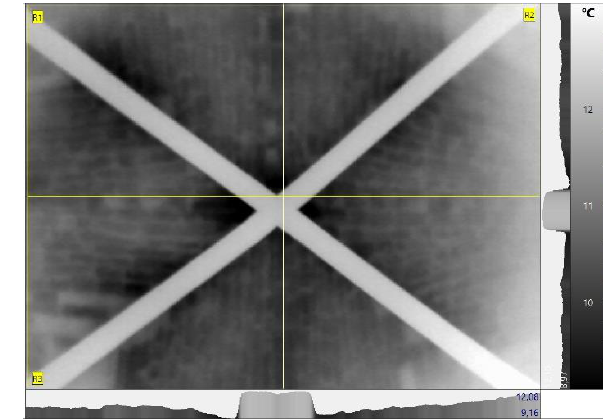
Figure 6: Thermogram of the plastered masonry vault in bay two. depicting joint structure, stone dimensions and variety of material characteristics.